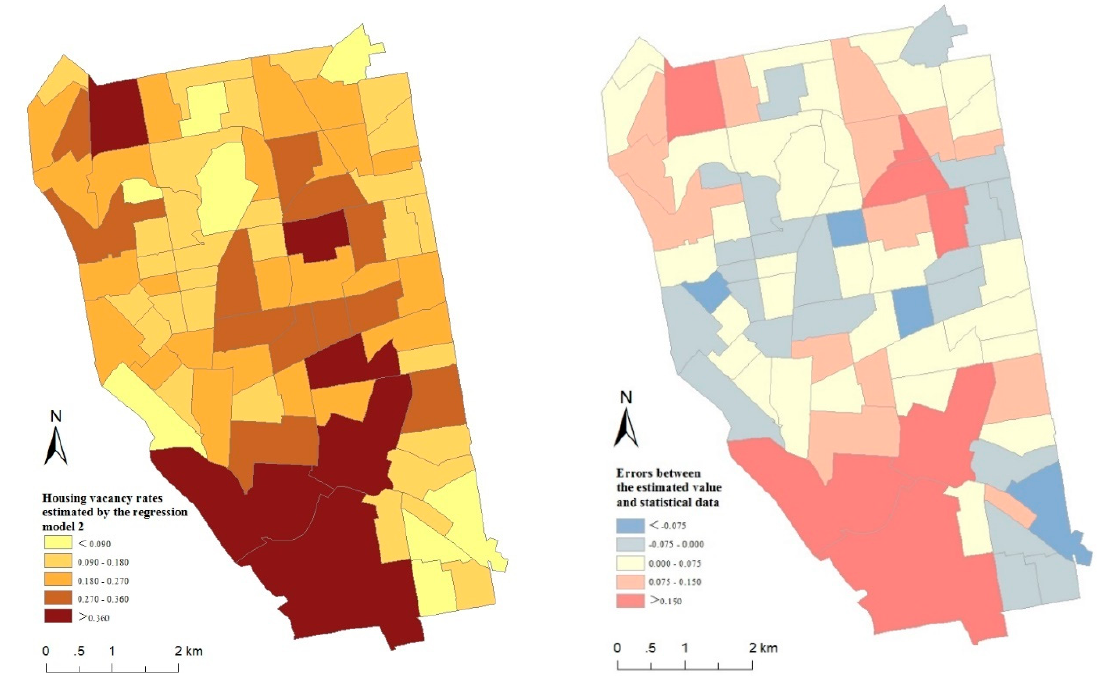
Figure 8. A distribution map of ( a ) the estimated HVR in Buffalo; ( b ) differences between the estimated value from our model and the Census Bureau statistical data.